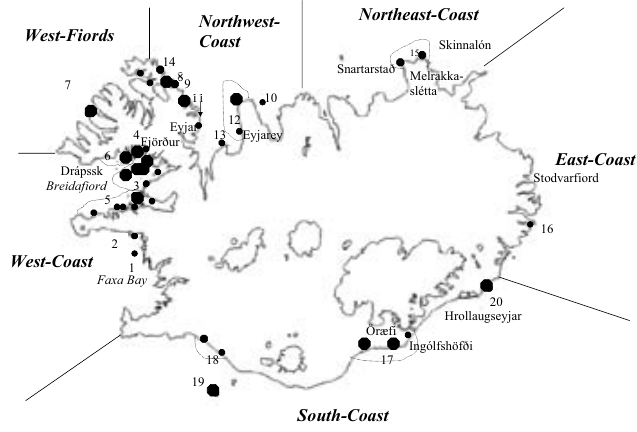
Fig. 2. Distribution of grey seals in Icelandic waters. Division of the coast into areas and main rookeries: Hvalseyjar (1), Tjaldursey - jar (2), Frameyjar (3), Skálmarnes